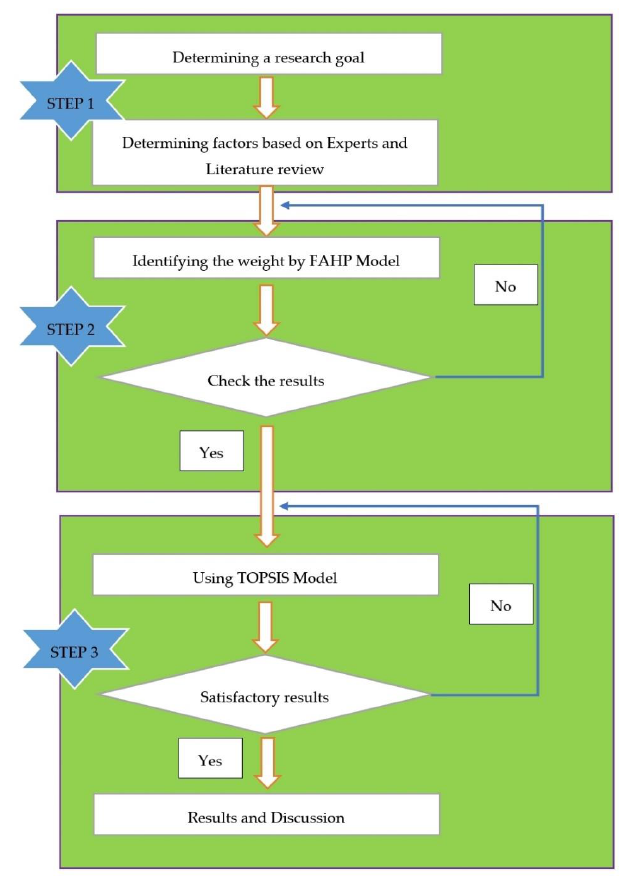
Figure 3. Diagram of research. FAHP — fuzzy analytic hierarchy process.